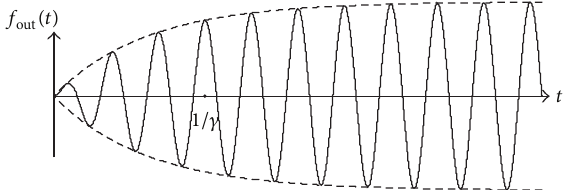
Figure 3: The illustration, for 𝑄 = 10 , of the resonant response of a second-order circuit. Note that we show a case when the excitation is precisely at the resonant frequency, and the notion of “purely resonant oscillations” applies here to the whole process, and not only to the final steady-state